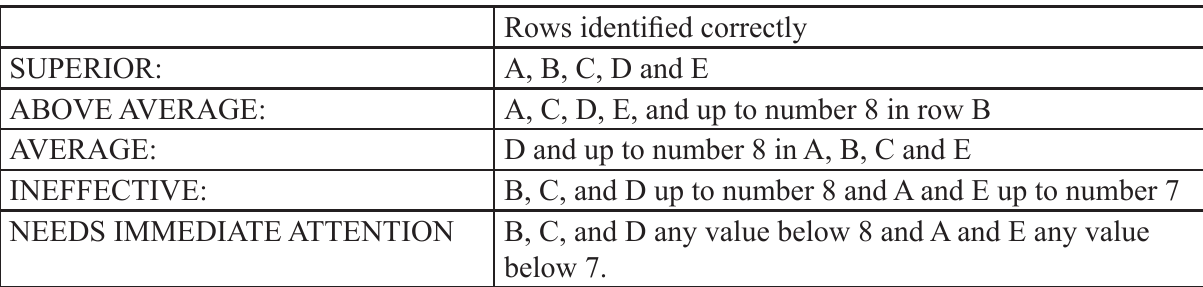
Table 3: The norms obtained for Contrast Sensitivity by means of the Functional Acuity Contrast Test Rows identified